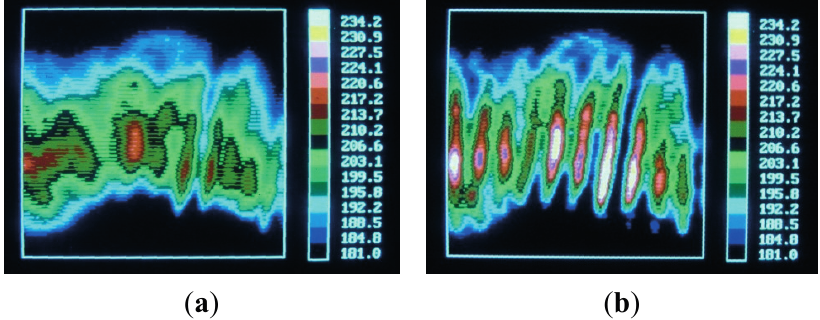
Figure 15. Images of Görtler vortices on a 15° ramp placed downstream of a 70°